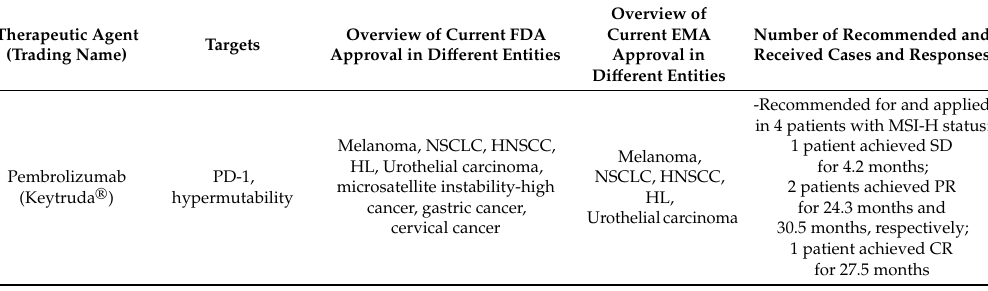
Figure 2. ( a – n ) These original images of immunohistochemistry show the differences between low and high expressions of various markers (Images by kind courtesy of Professor Dr. Müllauer). Table 3. Rationale for targeted therapy